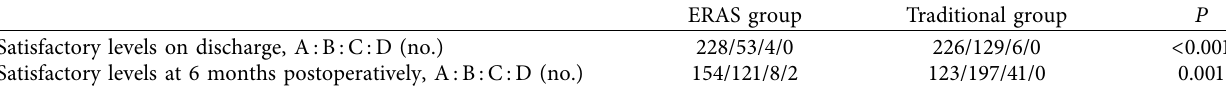
Table 4: Satisfaction level of both groups.